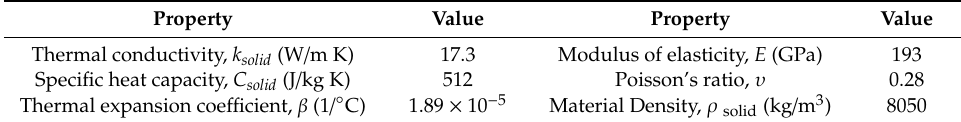
Table 3. Mechanical and thermal properties of absorber